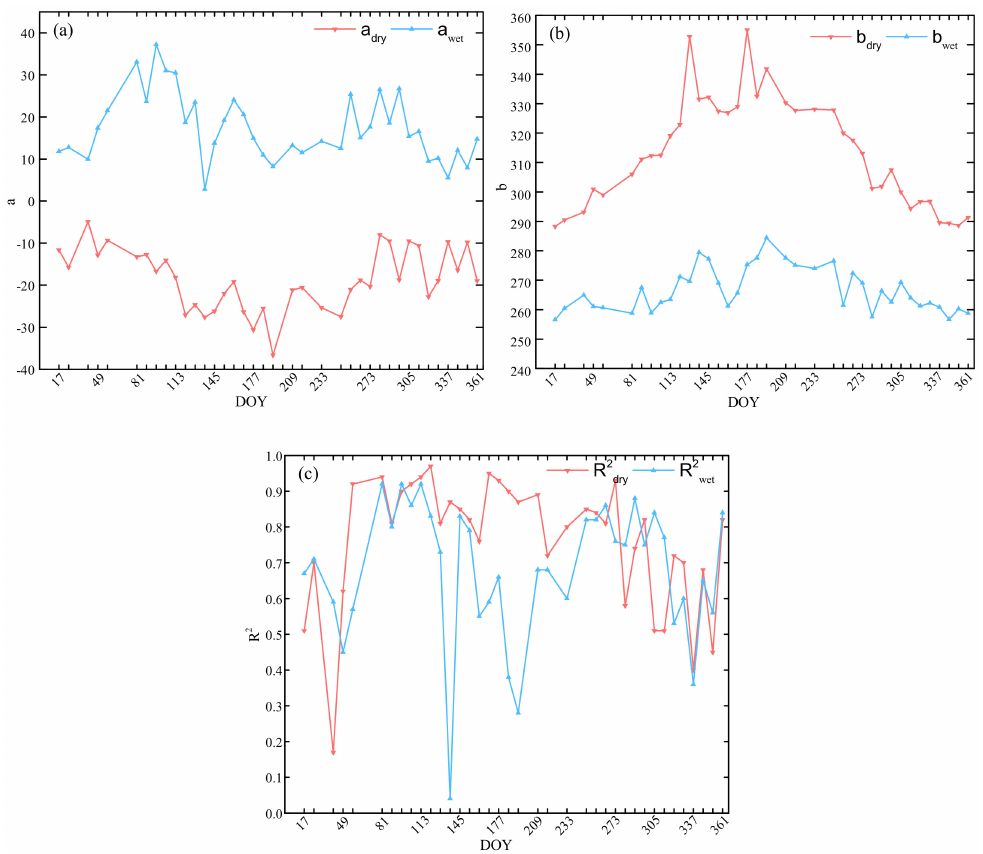
Figure 9. The parameters of the dry and wet edges over the 38 periods in 2017. ( a ) Slopes: a dry and a wet , ( b ) intercepts: b dry and b wet , ( c ) correlation coe ffi cients: R 2